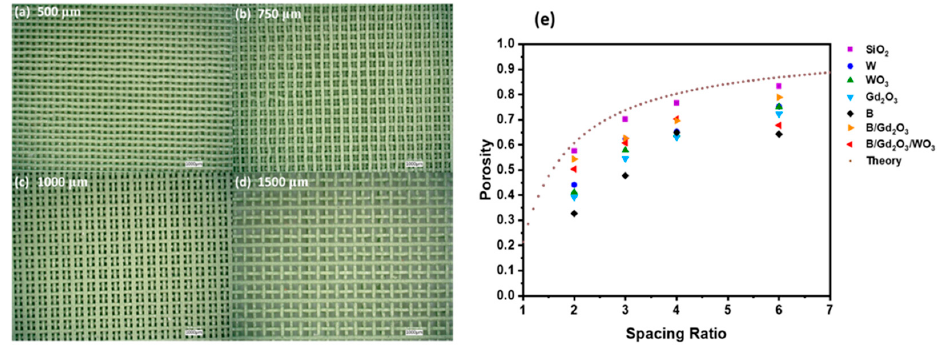
Figure 3. Porosities of the printed formulations at varying spacing ratios, with microscopy images of WO 3 at ( a ) 500 µm or η = 2; ( b ) 750 µm or η = 3; ( c ) 1000 µm or η = 4; and ( d ) 1500 µm or η = 6; and ( e ) comparing the porosities of the printed samples along with the theoretical 3D-printed porosities.